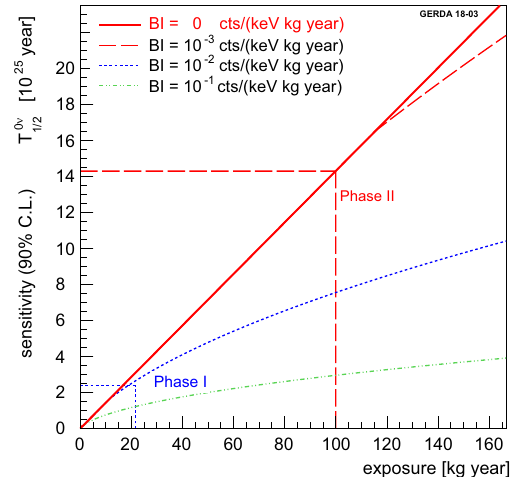
Fig. 2 Frequentist’s estimate of the sensitivity of the Gerda experi- mentasafunctionofexposureforvariousbackgroundindices.Anover- all detection efficiency of 60% is assumed. The scenarios for Gerda Phase I and II are